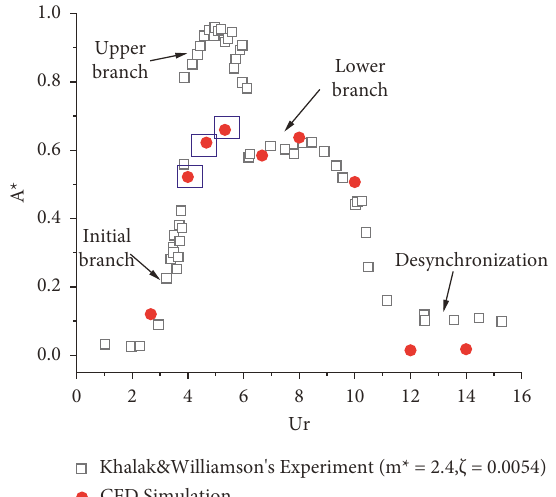
Figure 5: Amplitude response of the cylinder VIV.